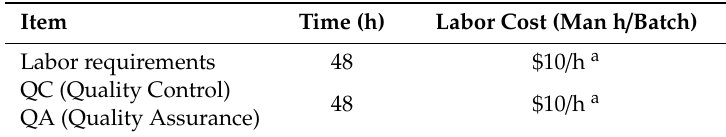
Table 8. Labor cost estimation of reductive